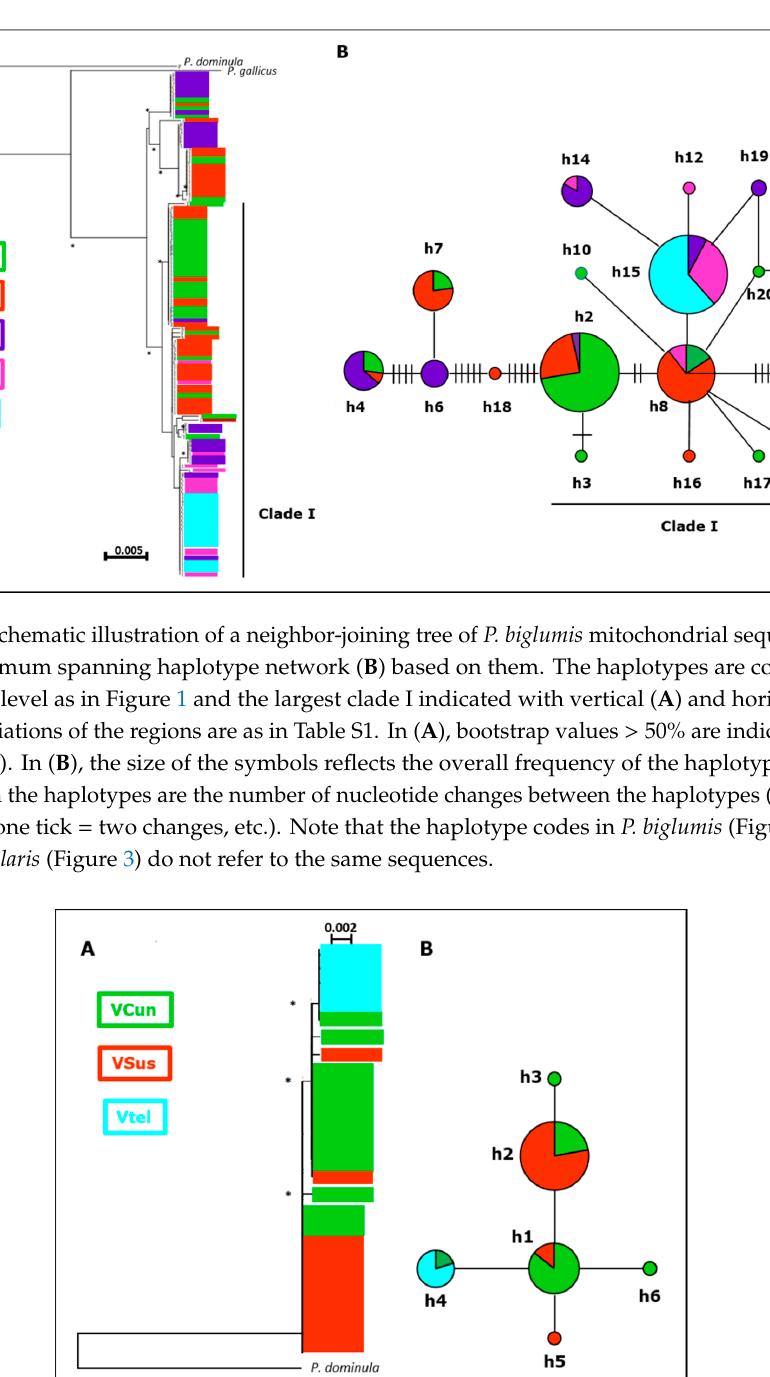
Figure 4. Isolation-by-distance in nuclear ( A ) and mitochondrial ( B ) markers in P. biglumis . In panel A, open circles and dashed line are for DNA microsatellites and closed circles and solid line for AFLP markers. In nuclear markers, only populations with n > 2 were included. Matrix correlation was significant in DNA microsatellite and mitochondrial markers, but not in AFLP markers. 4. Discussion 4.1. Spatial Genetic Structure Our results suggest that the host P. biglumis forms panmictic populations across areas covering several tens of kilometers and dominated by high mountains. Populations are significantly differentiated from each other only among more distant major geographical areas in an isolation-by- distance fashion. This pattern emerges both from nuclear and mitochondrial markers, and it is corroborated by multiple analyses. In AMOVA, a clearly larger proportion of genetic variation was allocated to the among-regions level than to the among-populations level in all markers, and the corresponding fixation indices were significantly larger than zero only at the among-regions level (Table 2). Bayesian clustering analysis failed to find any clusters in the DNA microsatellite data (K = 1) and made an arbitrary clustering for the AFLP data (K = 9), which both are consistent with ample gene flow among populations. A similar mixed pattern was found in the mitochondrial sequence